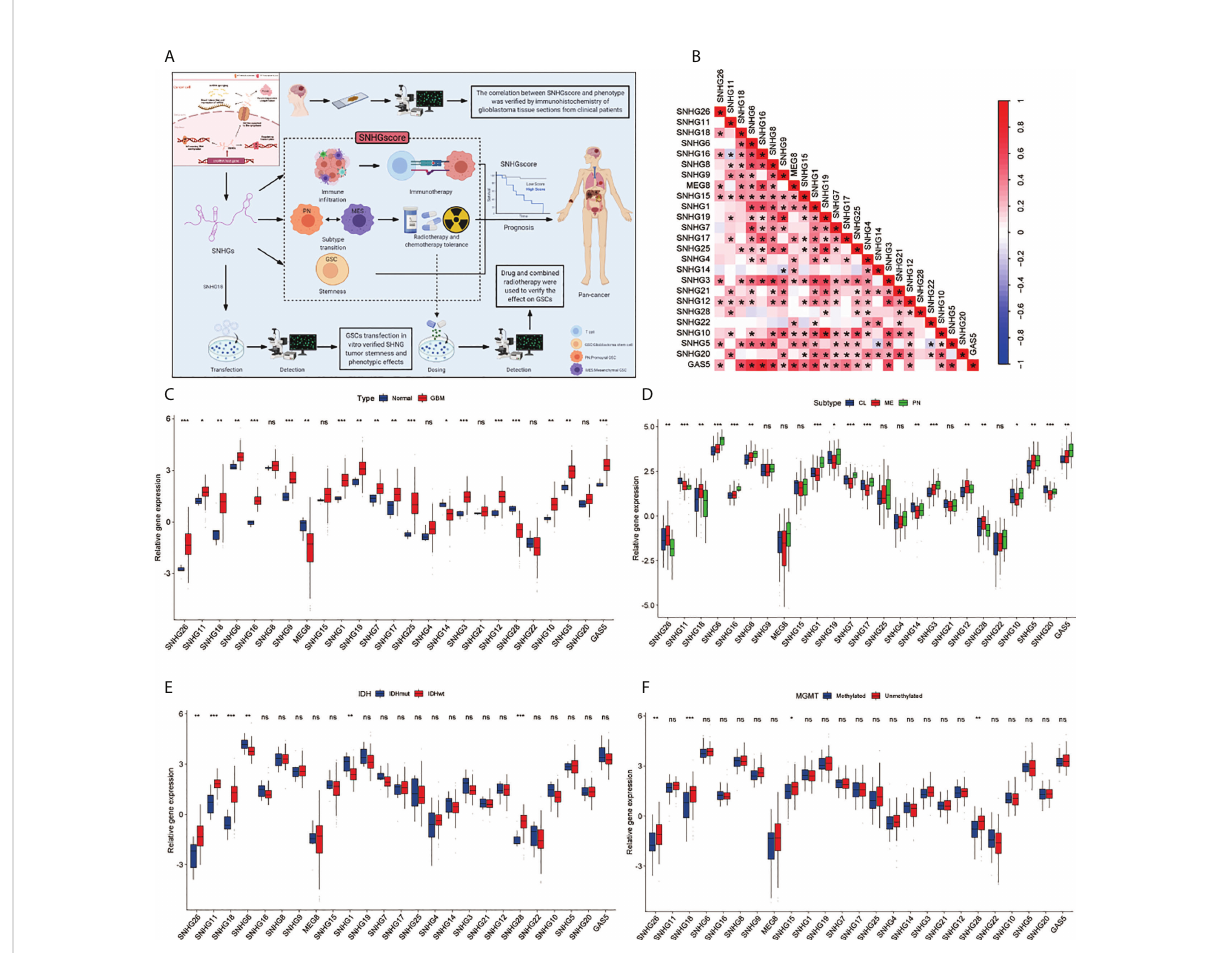
FIGURE 1 Landscape of Clinical features of SHNGs in GBM. (A) Article research ideas and several main mechanisms of SNHG in cancer cells. (B) The correlations between the 25 SNHGs were calculated in GBM using the Spearman correlation analysis. (*P<0.05). (C) The expression of 25 SNHGs between normal and GBM tissues in TCGA. (D) The expression of 25 SNHGs between TCGA GBM subtypes. (E) The expression of 25 SNHGs between IDH mutant and IDH wild subtypes in TCGA. (F) The expression of 25 SNHGs between methylated modi fi cation and unmethylated modi fi cation. All data are presented as the means ± SD, ns, P > 0.05, *P < 0.05, **P < 0.01, ***P <